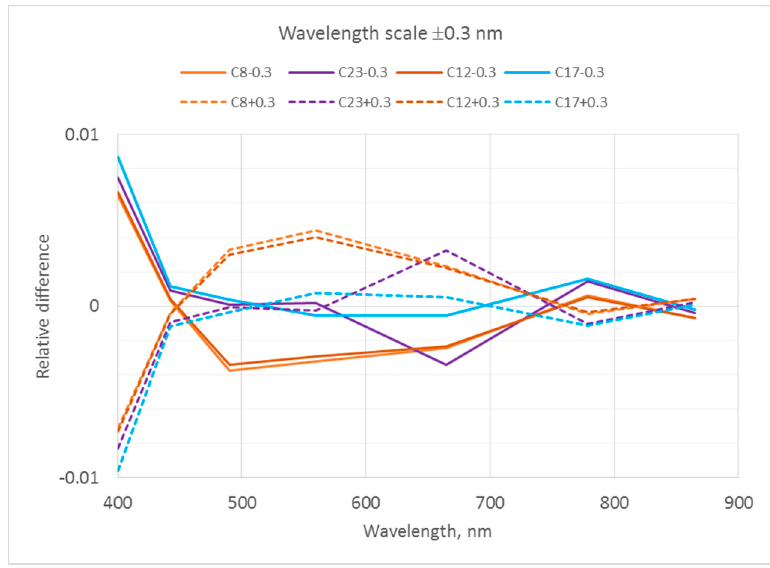
Figure 16. Relative variability due to wavelength error of ± 0.3 nm of a radiance sensor.